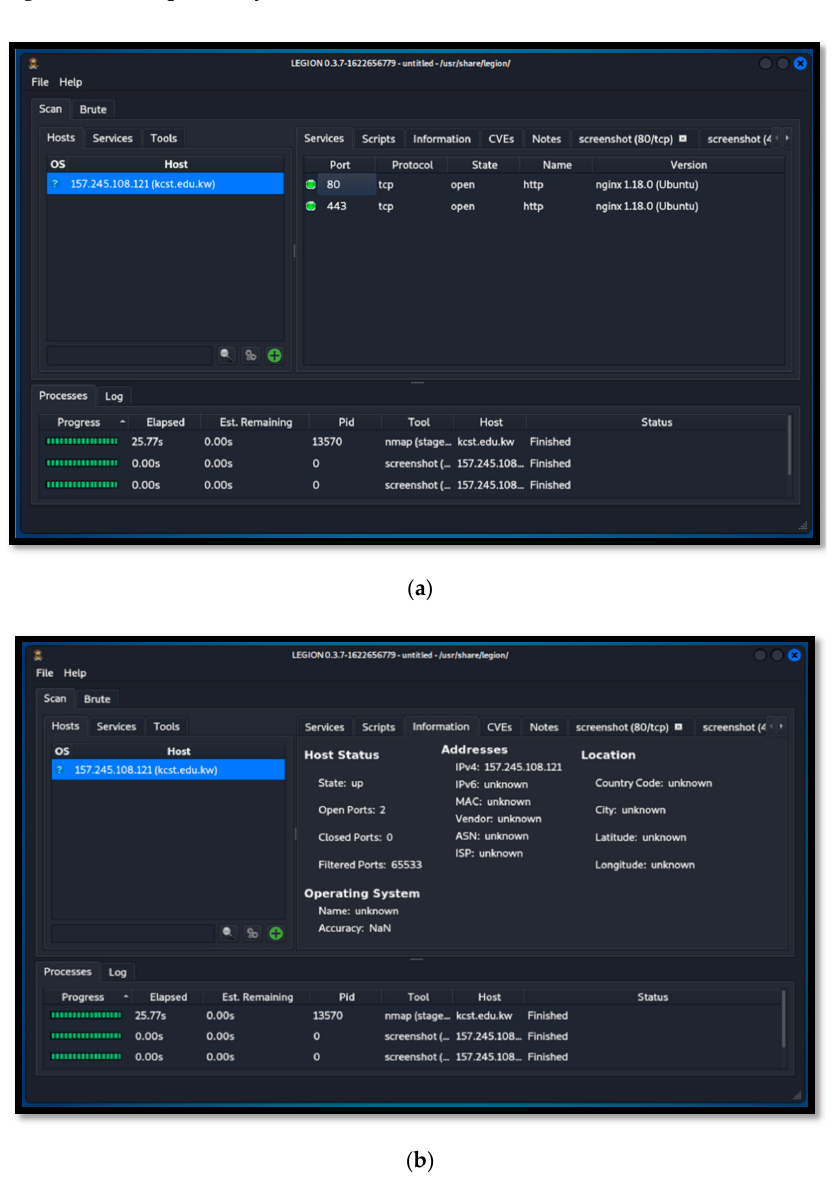
Figure 7. ( a ) Selecting the victim; ( b ) the IP address and port